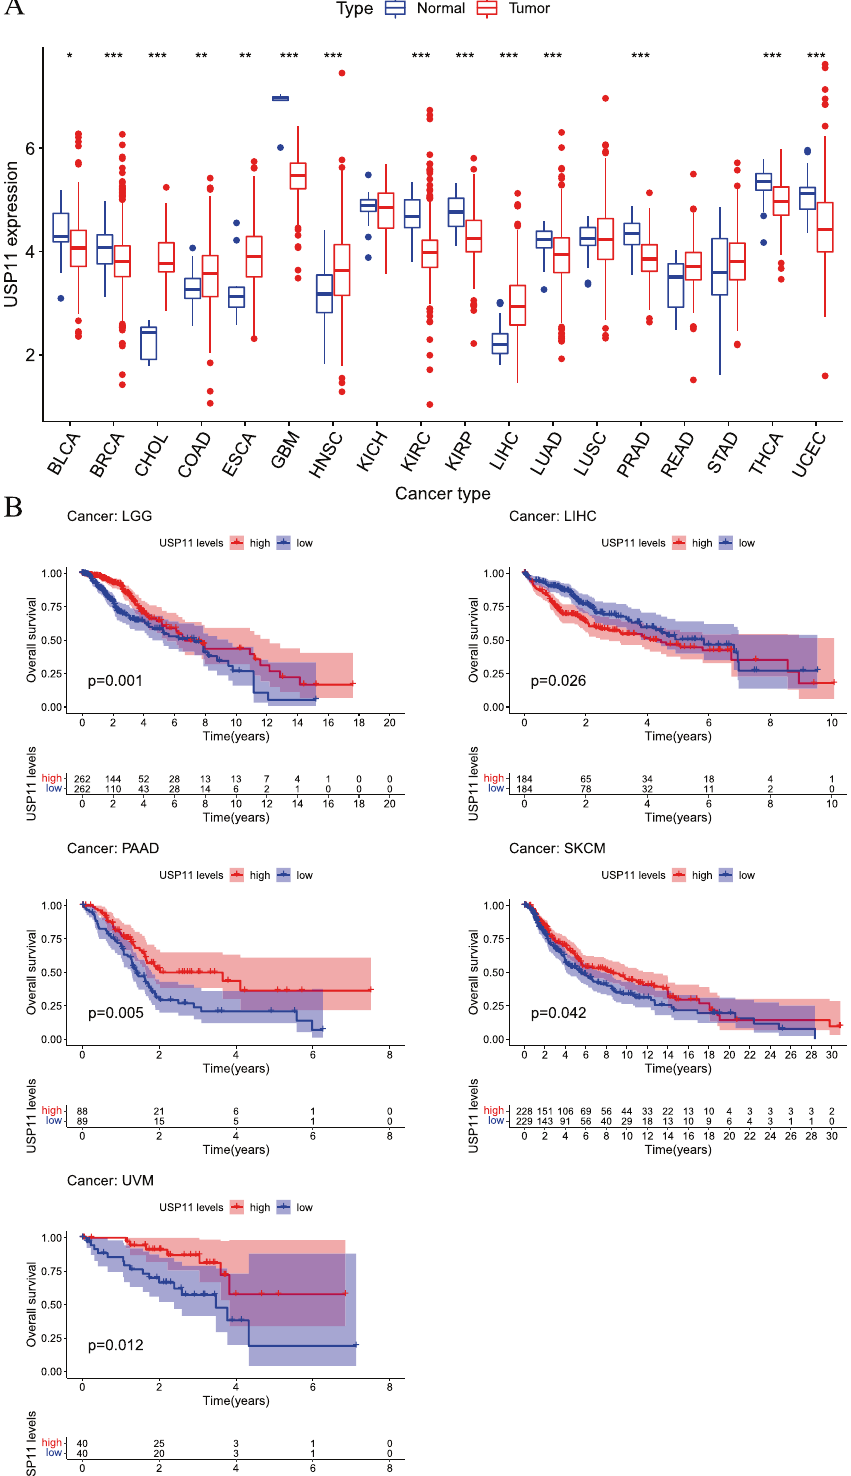
Fig. 3 USP11 expression in pan-cancer and paired para-cancer tissue and Kaplan – Meier analysis. A The expression of USP11 in pan-cancer and paired para-cancer tissues based on bioinformatics analysis. B Kaplan – Meier analysis between USP11 expression and low-grade glioma (LGG); liver hepatocellular carcinoma (LIHC), pancreatic cancer (PAAD), skin cutaneous melanoma (SKCM), and uveal melanoma (UVM).